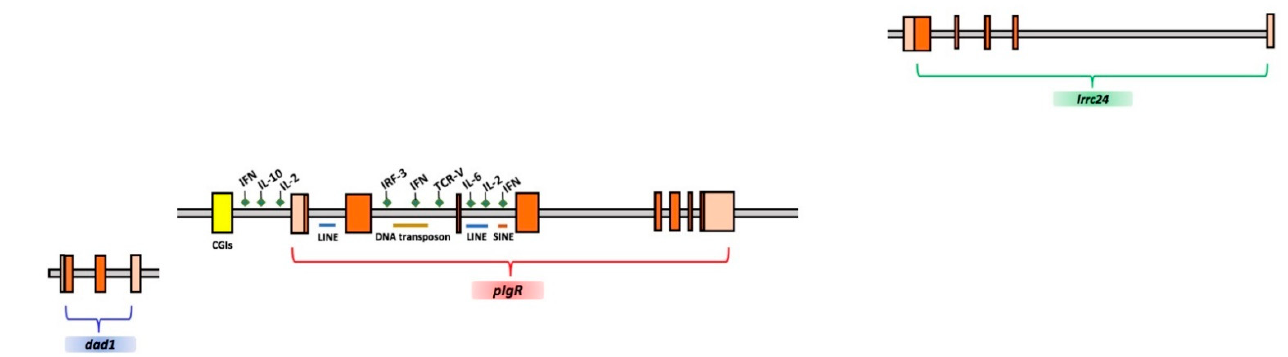
Figure 3. Schematic representation of the organization of the pIgR gene locus in T. bernacchii . Exons are indicated in orange boxes, promoter and terminal sequences are indicated in bright orange, and the CpG islands (CGIs) are indicated in yellow. Putative transcription factor binding sites (green diamonds) and TEs (blue, ocher, and brown lines) are indicated above and below the scheme, respectively. dad1 and lrrc24 flanking genes are also